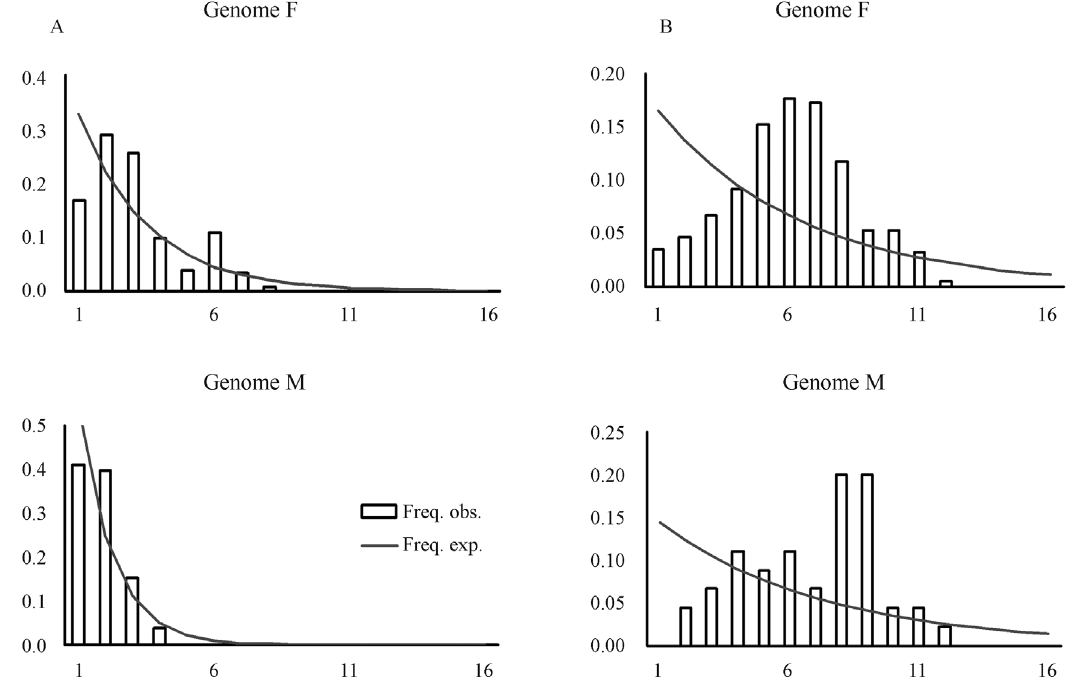
Figure 2 - Frequency distribution graphs of the number of mutations between pairs of sequences (mismatch distribution), obtained from the 16S mito- chondrial gene (A) and COI gene (B) for the two genome types, F and